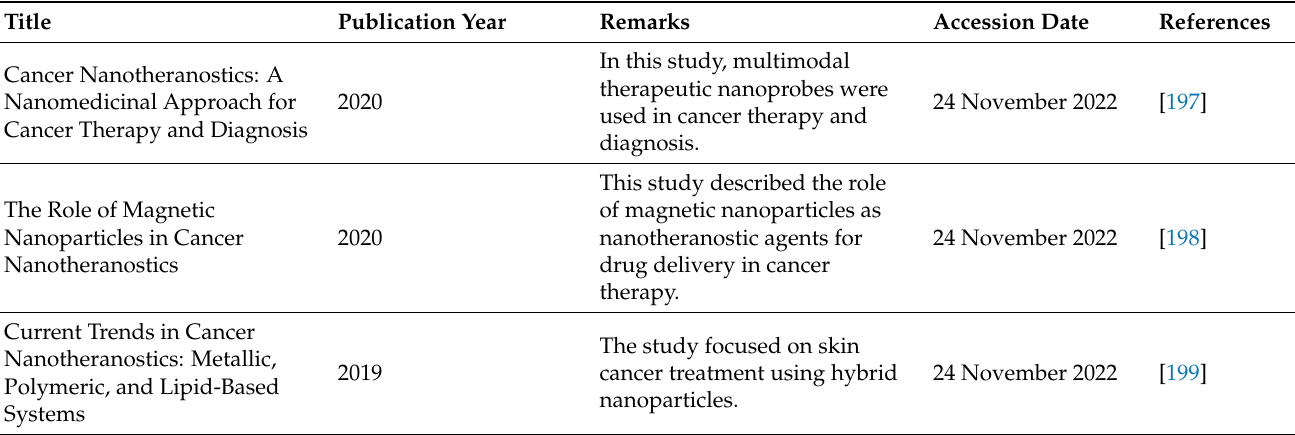
Table 16. Recent literature studies on nanotheranostic cancer